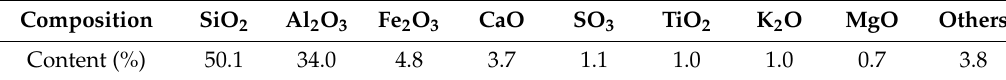
Table 1. Chemical composition of UFA.